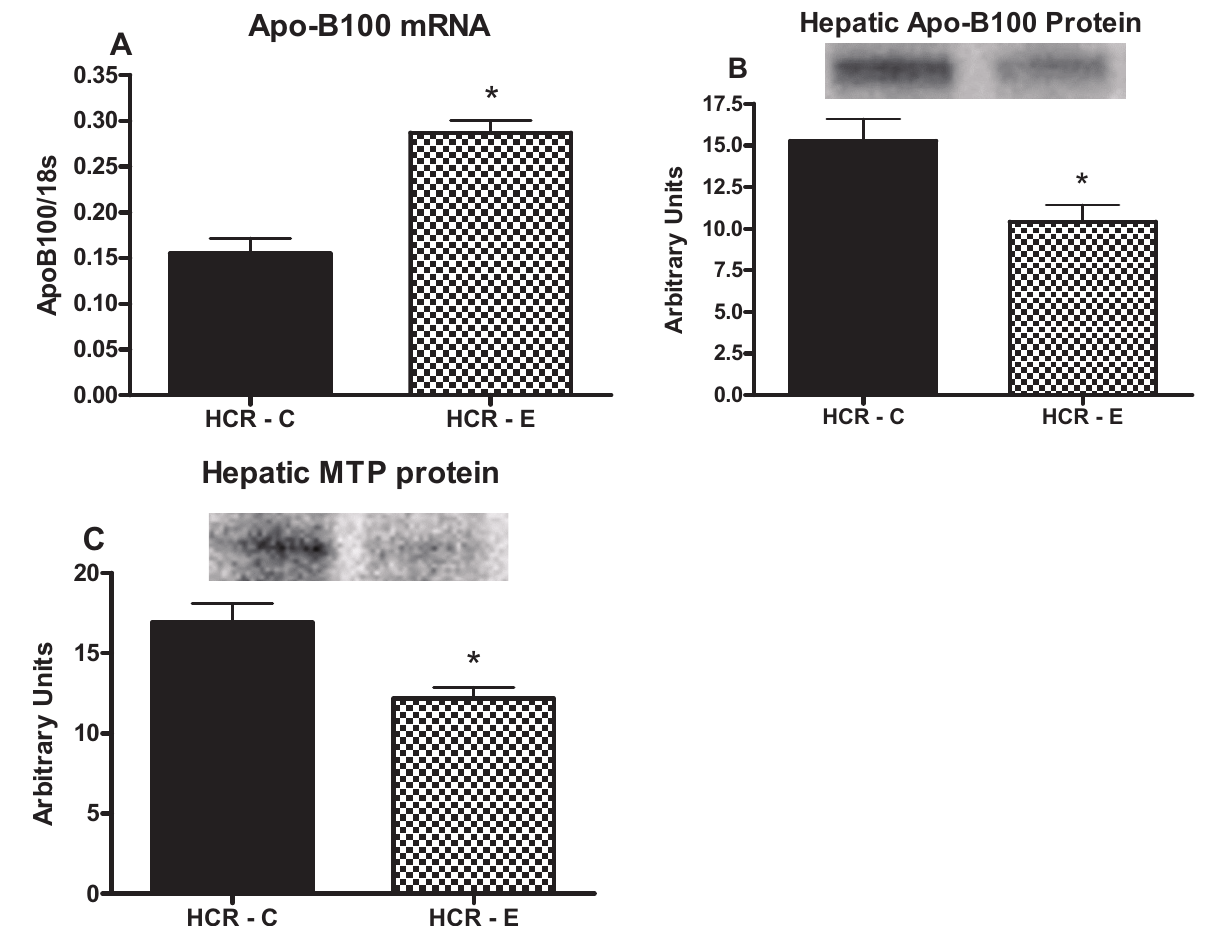
Figure 4. Effects of ethanol on markers of TG export apoB-100 mRNA ( A ); protein content of apoB-100 ( B ); and protein content of microsomal triglyceride transfer protein (MTP) ( C ). Values (means ± SE) with * are significantly different ( p < 0.05); n =